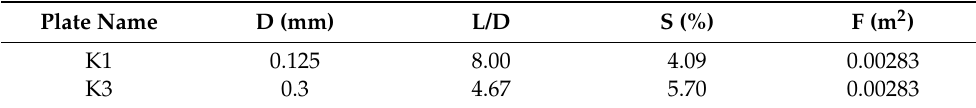
Table 1. Plates parameters in the